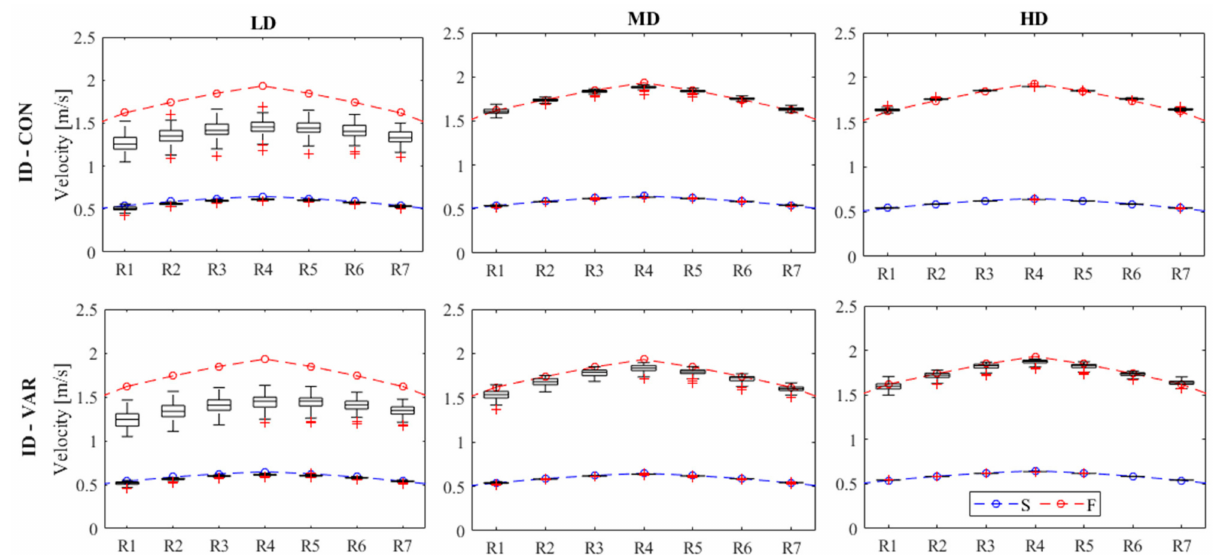
Figure 10. Comparison between imposed (in the ISG) surface velocity profiles for the reference transect (cross-section T3) and the corresponding velocities estimated by PIVlab at each node of the same transect (from R1 to R7). The imposed profiles are reported by blue dashed curves for the slow (S) velocity cases and red dashed curves for the fast (F) velocity cases. The estimated velocities are reported in the form of boxplot of MAPE including the results of all the 100 replications per scenario. The three top graphs refer to the scheme ID-CON, while the bottom graphs to the scheme ID-VAR. For each scheme, the low (LD), medium (MD), and high (HD) density scenarios are reported on the left, middle and right graph, respectively (first set of simulations: frame-rate = 4 fps, d = 30